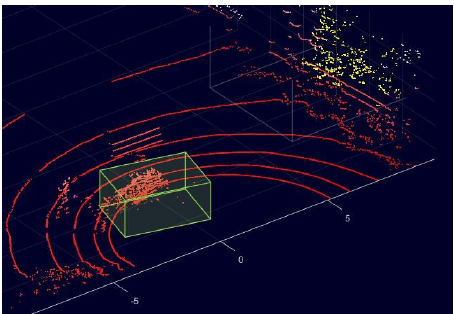
Figure 7. Labeling data in MATLAB LiDAR labeler app: The points inside a yellow cube are considered as